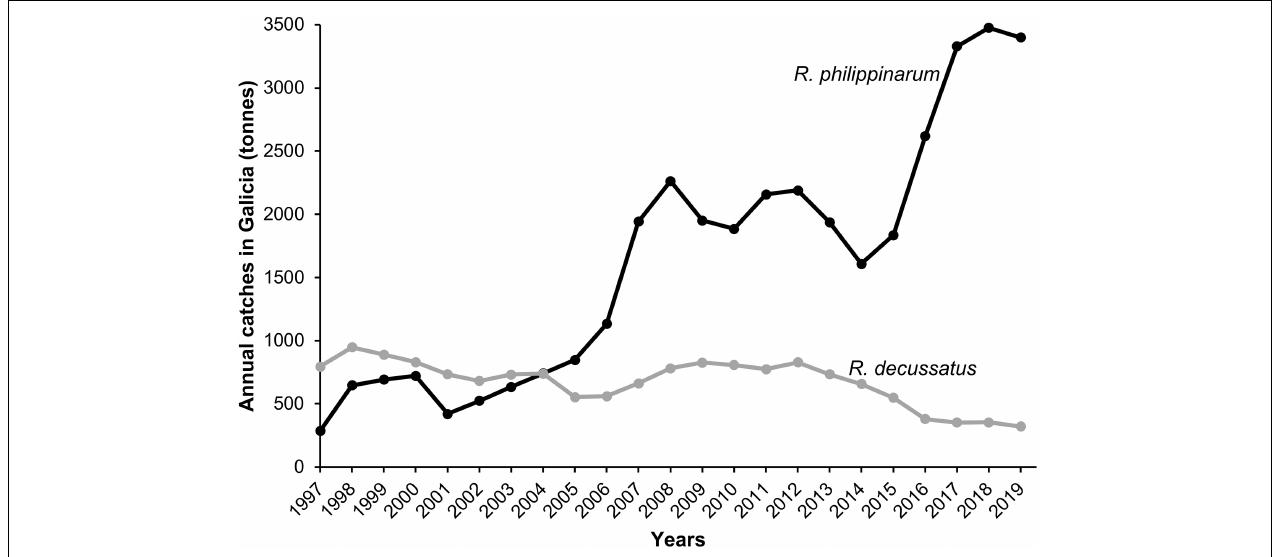
FIGURE 9 | Evolution of the annual catches in Galicia (tonnes) from 1997 until 2019 of Ruditapes decussatus and Ruditapes philippinarum (data from www.pescadegalicia.gal).